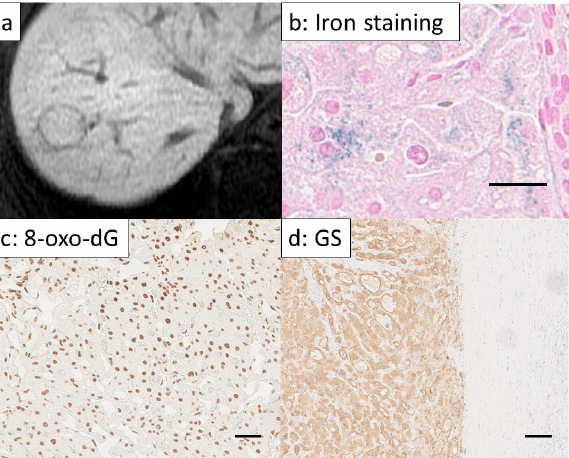
Figure 3. Gd-EOB-DTPA-enhanced MRI image and immunohistochemical staining of hepatocellular carcinoma cases with high serum ferritin level and showing a high signal in the hepatobiliary phase of Gd-EOB-DTPA-enhanced MRI. ( a ) Gd-EOB-DTPA-enhanced MRI (hepatobiliary phase). The tumor showed a high signal. RER = 1.01. ( b ) Iron staining (Berline blue staining) of a non-cancerous area in the liver (×800). Scale bar = 15 μ m. Iron deposits were found in the liver tissue of the non-cancerous area. ( c ) Strong 8-oxo-dG staining of non-cancerous area in the liver (×400). Scale bar = 50 μ m. ( d ) GS staining at the border between cancerous and non-cancerous areas (×200). Scale bar = 25 μ m. It is likely that Wnt/ β -Catenin signaling had been activated in this case because the tumor tissue located on the left side of the image was strongly stained.